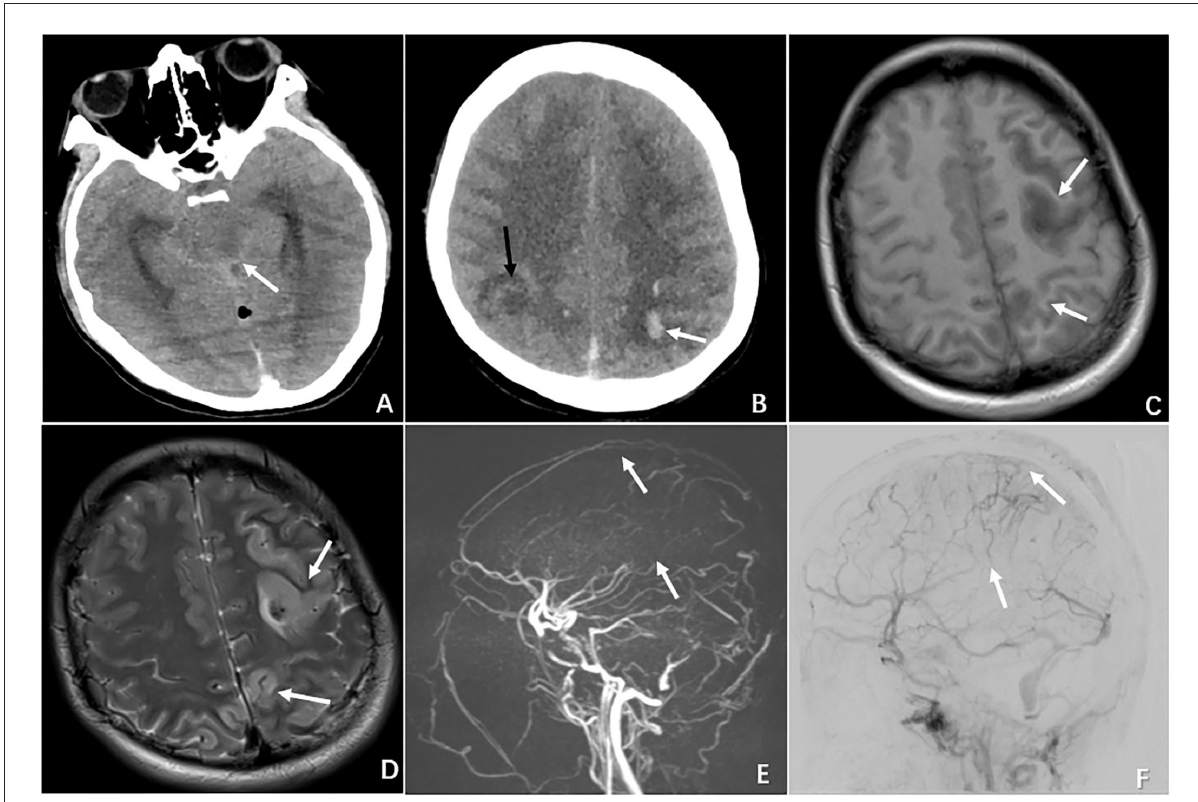
FIGURE1 Radiographic features of CVT in the case of N6 who presented with severe neurological deterioration. (A) Non-contrast CT demonstrating brain swelling and ambient cistern compression (white arrow). (B) CT demonstrating multiple ischemic infarctions (black arrow) with a hemorrhagic component (white arrow). (C) MRI showing a left hyperintense lesion with a surrounding hypointense area on T1-weighted MRI. (D) MRI demonstrating the same hypointense lesion with a surrounding large hyperintense area on T2-weighted MRI. (E) MRV showing complete occlusion of the superior sagittal sinus (superior arrow) and inferior sagittal sinus (inferior arrow). (F) DSA demonstrating occlusion of the superior sagittal sinus (superior arrow) and inferior sagittal sinus (inferior